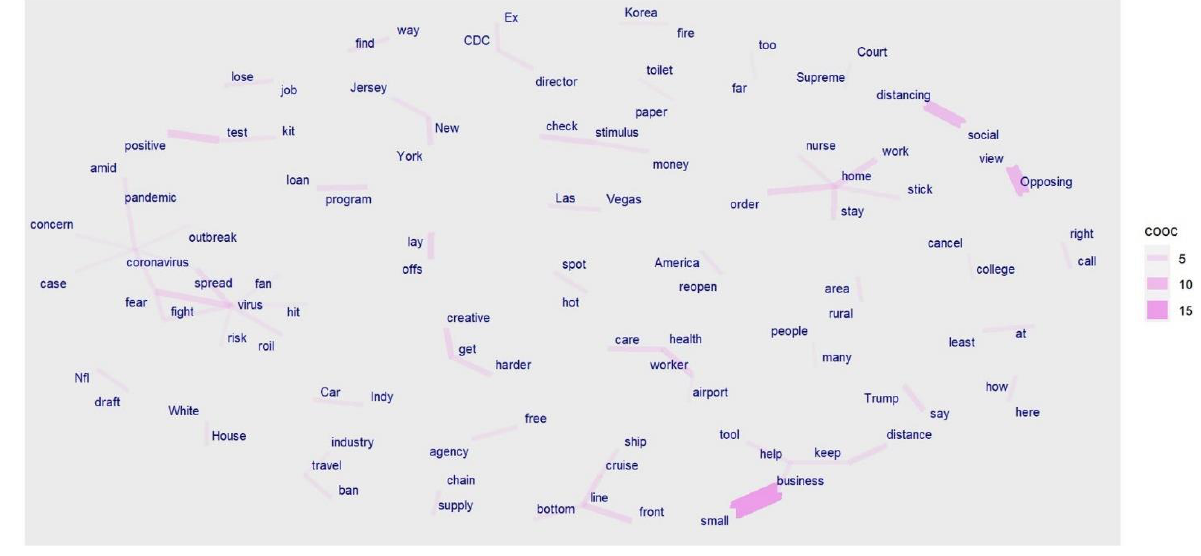
Figure 4. Words following one another (USA Today).